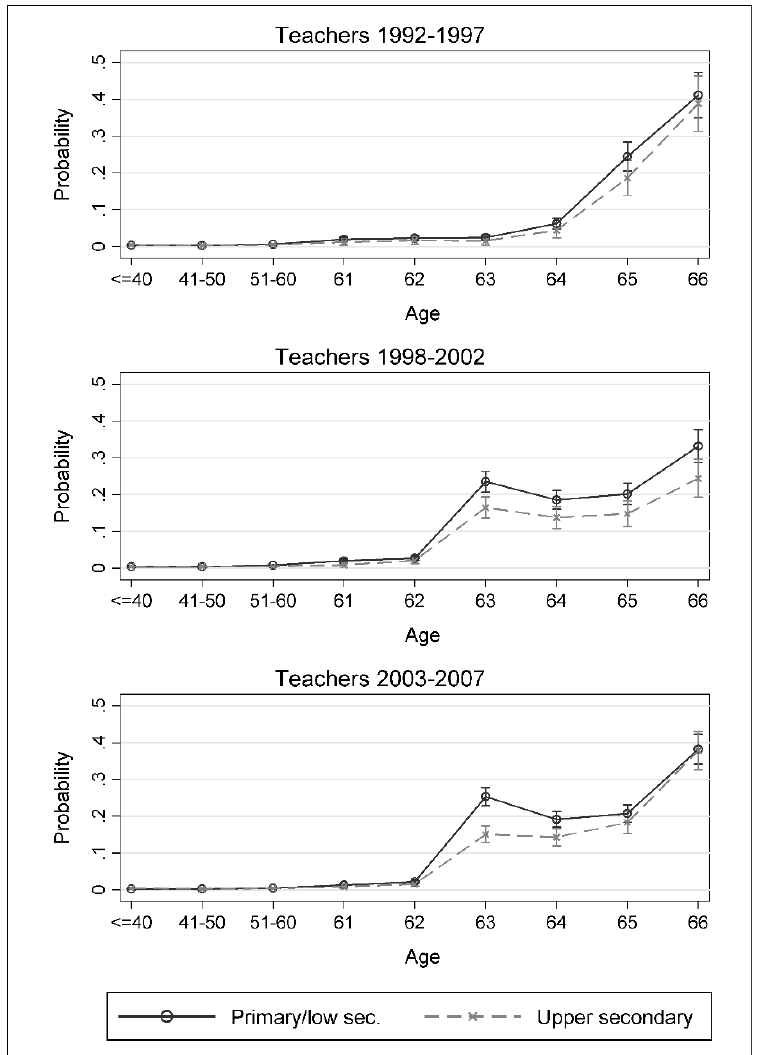
Figure 5. Annual attrition rates, exits to non-employment (retirement-exits), by school level in a previous year, time period, and age. 95% CI error bars. Predicted for female, no children < 8, bachelor’s graduate in humanities with PGCE, no fur- ther education, residing in central